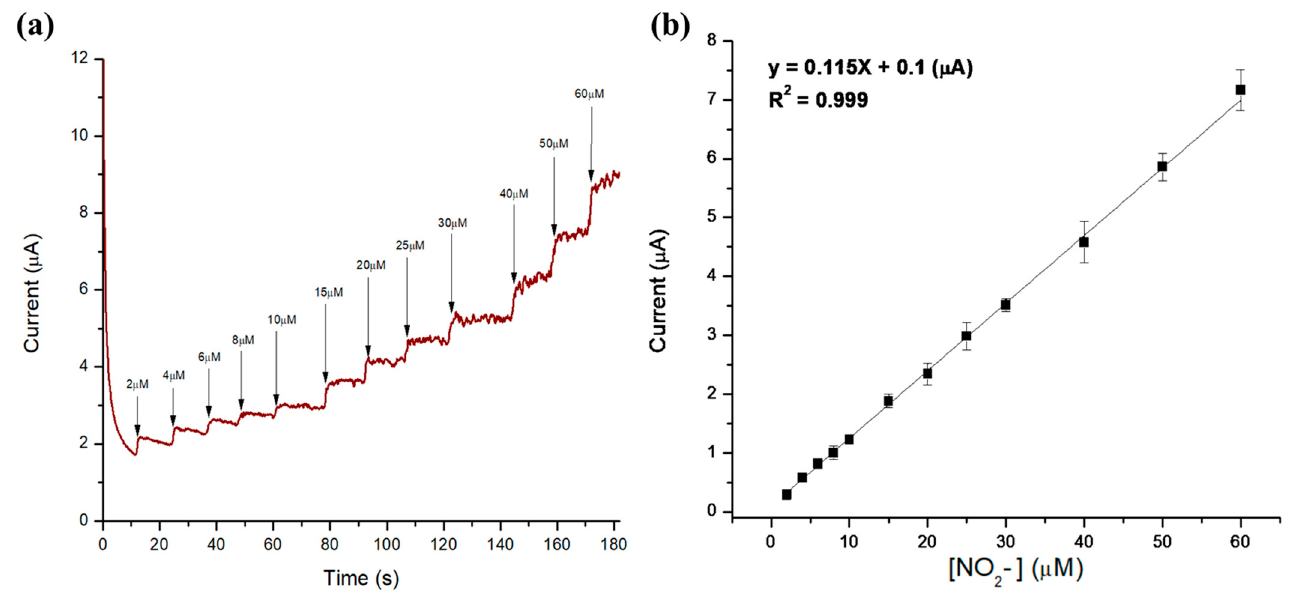
Figure 5. ( a ) Chronoamperometric ( i–t ) response of the PMBI/NGNPs coated electrode obtained in the solution containing nitrites extracted from bacon and after the addition of different concentrations of sodium nitrites. ( b ) Calibration plot as a function of the nitrite concentration. The applied potential was 0.86 V and error bars were calculated from three repeat measurements.